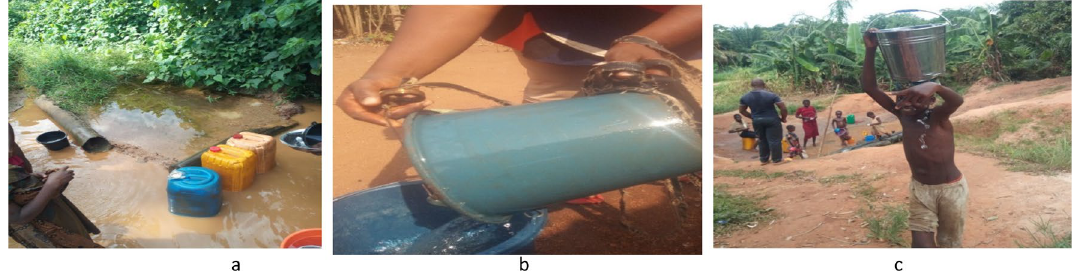
Fig. 3 a View of Ogbu stream, b woman fetching from Commodore hand-dug well c boy fetched from Ahala